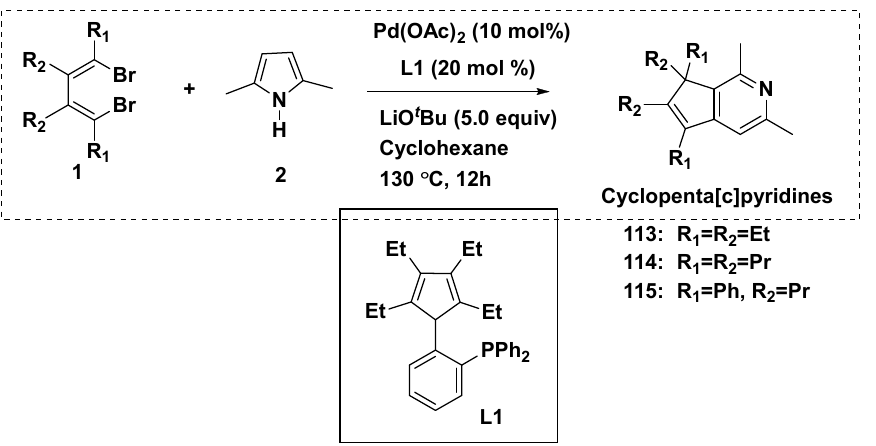
Scheme 12. Reactions afforded cyclopenta[c]pyridine derivatives.